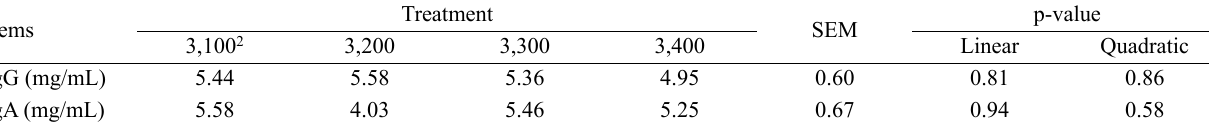
Table 8. Effects of the dietary energy level in gestating sows on immune parameters of colostrum 1 in primiparous lactating sows